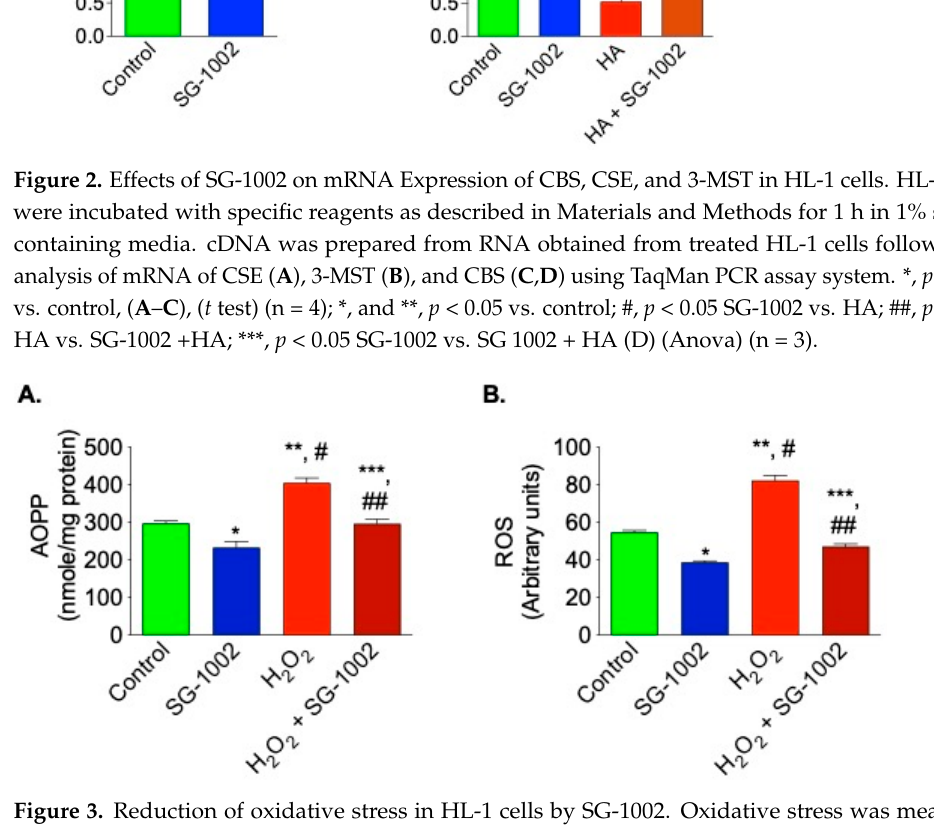
Figure 2. Effects of SG-1002 on mRNA Expression of CBS, CSE, and 3-MST in HL-1 cells. HL-1 cells were incubated with specific reagents as described in Materials and Methods for 1 h in 1% serum containing media. cDNA was prepared from RNA obtained from treated HL-1 cells followed by analysis of mRNA of CSE ( A ), 3-MST ( B ), and CBS ( C , D ) using TaqMan PCR assay system. *, p < 0.05 vs. control, ( A – C ), (t test) (n = 4); *, and **, p < 0.05 vs. control; #, p<0.05 SG-1002 vs HA; ##, p < 0.05 HA vs. SG-1002 +HA; ***, p < 0.05 SG-1002 vs. SG 1002 + HA (D) (Anova) (n = 3).